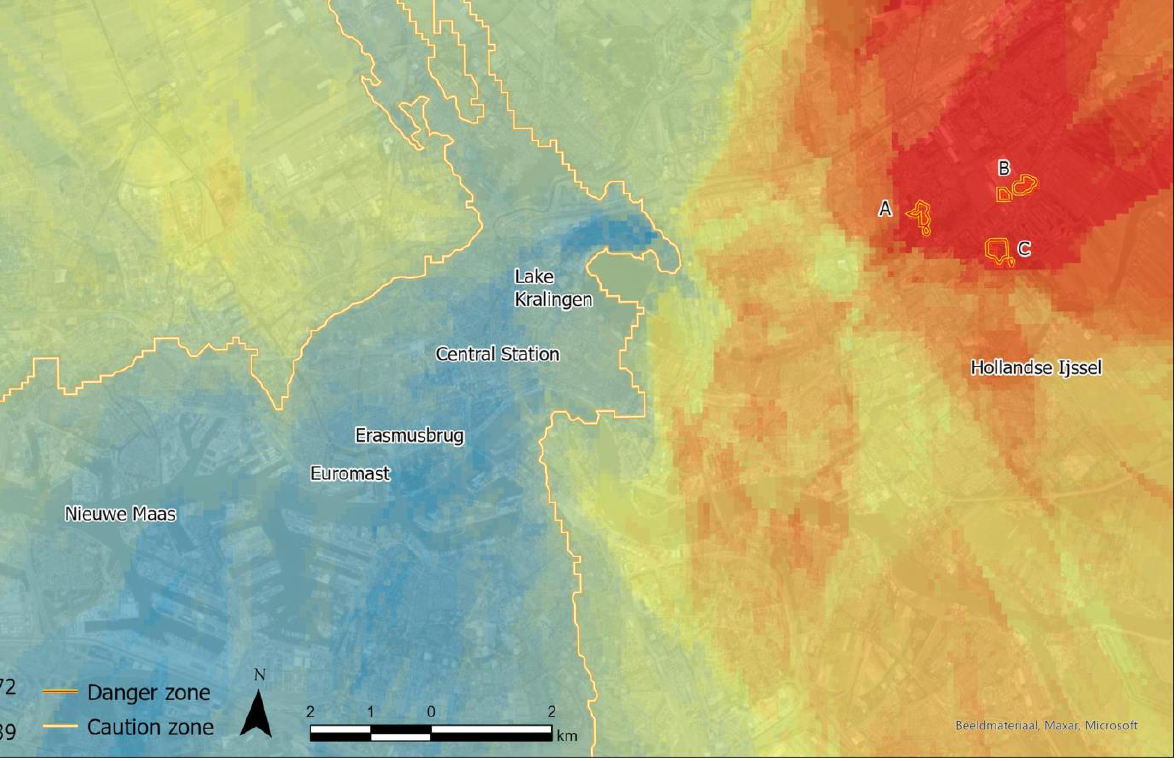
Figure 5. Humidex degree hour (HDH) map. HDH for a “typical” extreme heat alert day. A large part of the Rotterdam study area has HDH values higher than 48 (the caution area), and some small patches in the northeast corner have HDH values higher than 72 (the danger area). An HDH value of 72 corresponds to 12 consecutive hours, or half of the day, with an apparent temperature value of 35 ◦